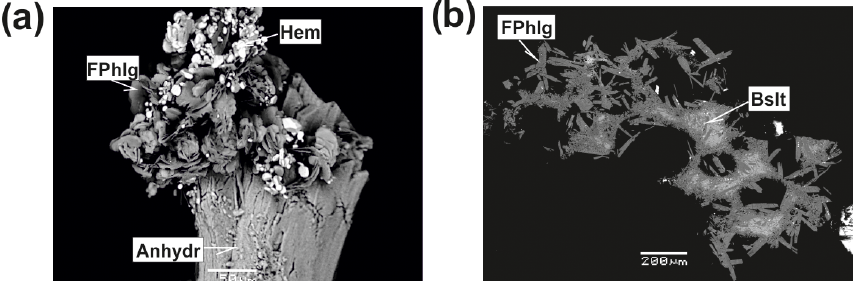
Figure 11. Fluorophlogopite (FPhlg) from the Arsenatnaya fumarole: (a) clusters powdered by hematite (Hem) on anhydrite (Anhydr); (b) aggregates replacing basalt scoria (Bslt). BSE images.